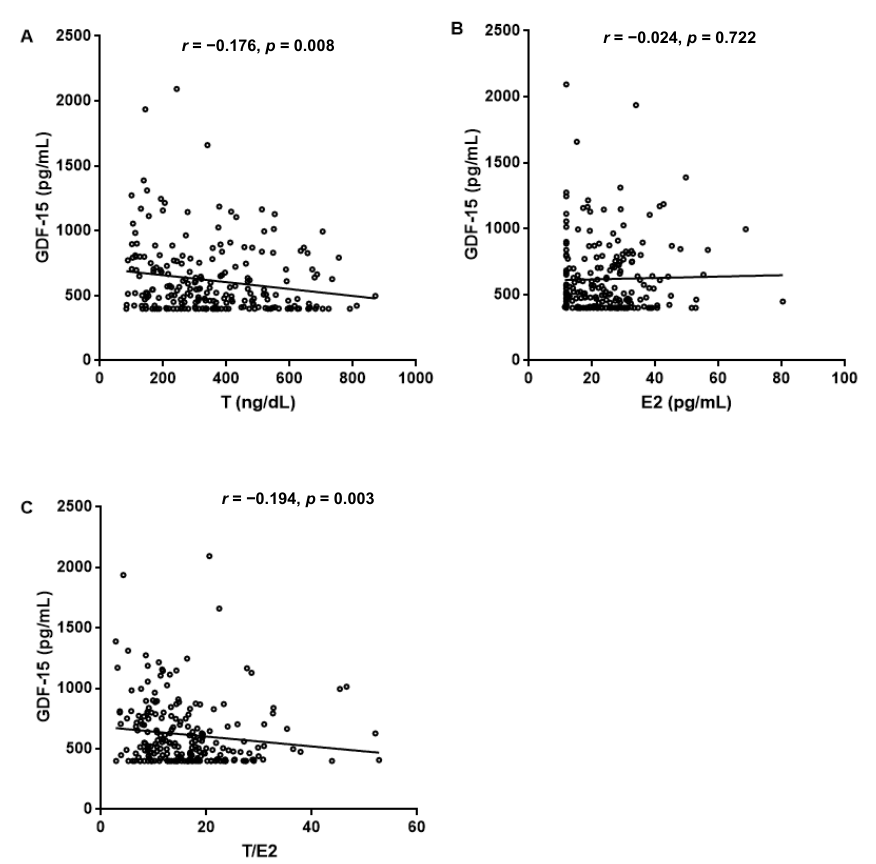
Figure 1. Spearman correlation between sex hormone and GDF-15 levels.